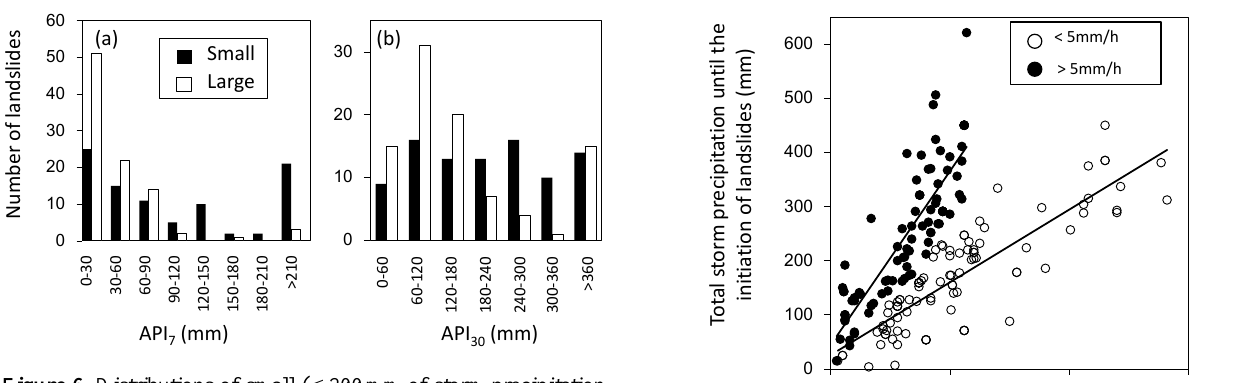
Figure 6. Distributions of small ( ≤ 200mm of storm precipitation up until the occurrence of the landslide) and large ( > 200mm pre- cipitation until the landslide) storms that triggered landslides for different levels of adjusted API 7 (a) and API 30 (b) .